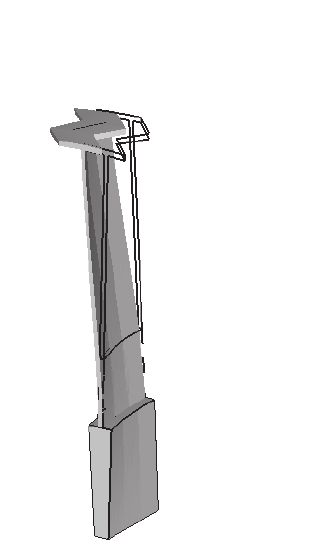
Figure 6: First eigenmode (bending mode). Figure 7: Crack propagation due to LCF and due to combined LCF+HCF.